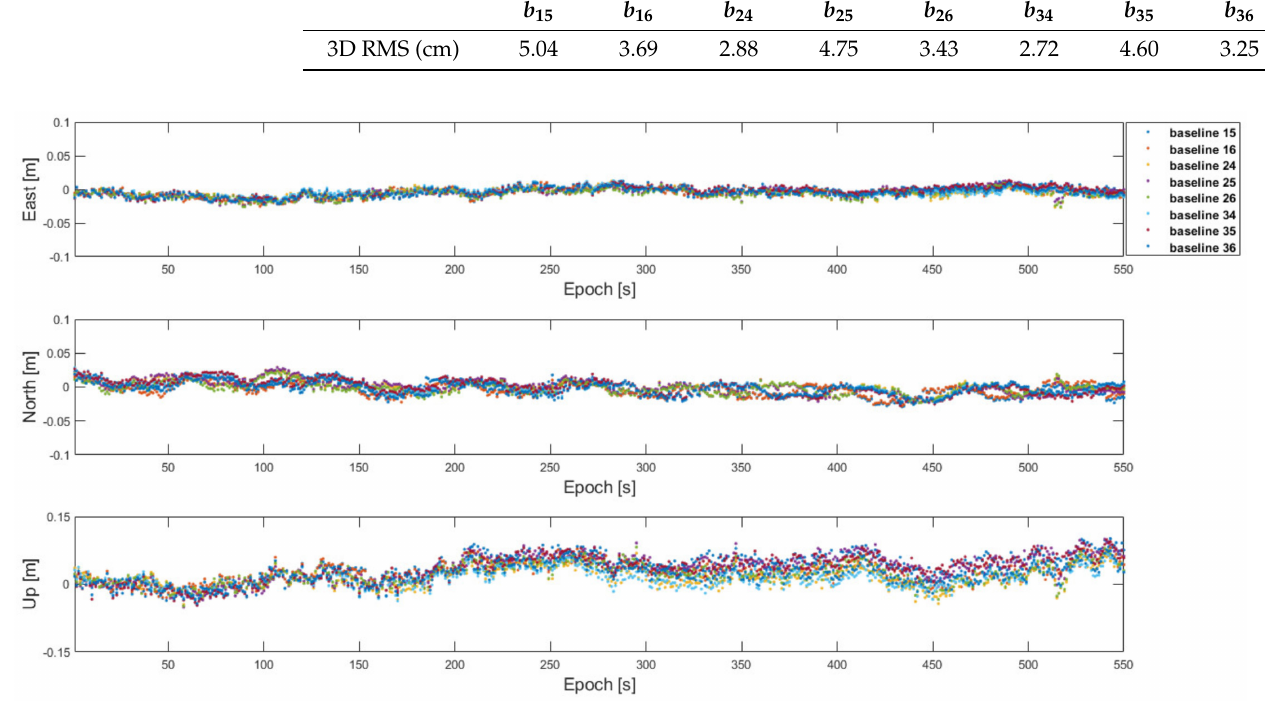
Figure 19. Position errors of the baselines across the two cells using all satellites in view and the broadcast integer ambiguities based on the proposed